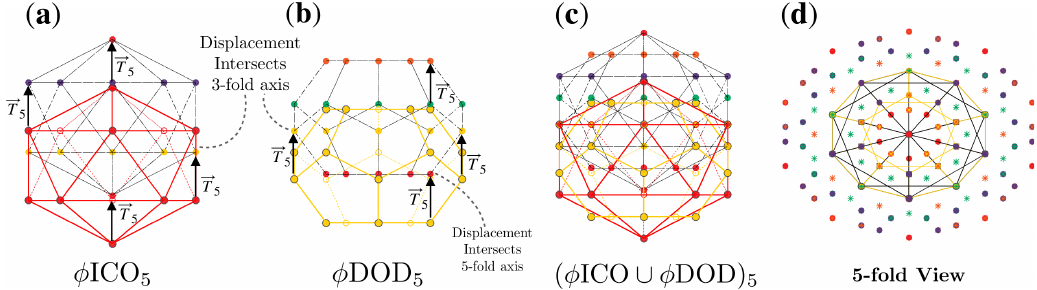
Figure 6. Formation of a double base point array. ( a ) Point array φ ICO 5 and ( b ) point array φ DOD 5 have the same affine extension (cid:126) T 5 and may therefore be combined to form ( c ) ( ICO ∪ DOD ) base point array. ( d ) A view down a 5-fold axes after applying icosahedral symmetry, where the points originating from φ DOD 5 are shown as asterisks ( (cid:83) ). All that is required to combine these two point arrays is that they have the same translation vector (cid:126) T 5 and it is coincidental that both φ ICO 5 and φ DOD 5 intersect at a 3-fold axes during the affine extension. The full radial distribution of points is shown in Figure 7a.